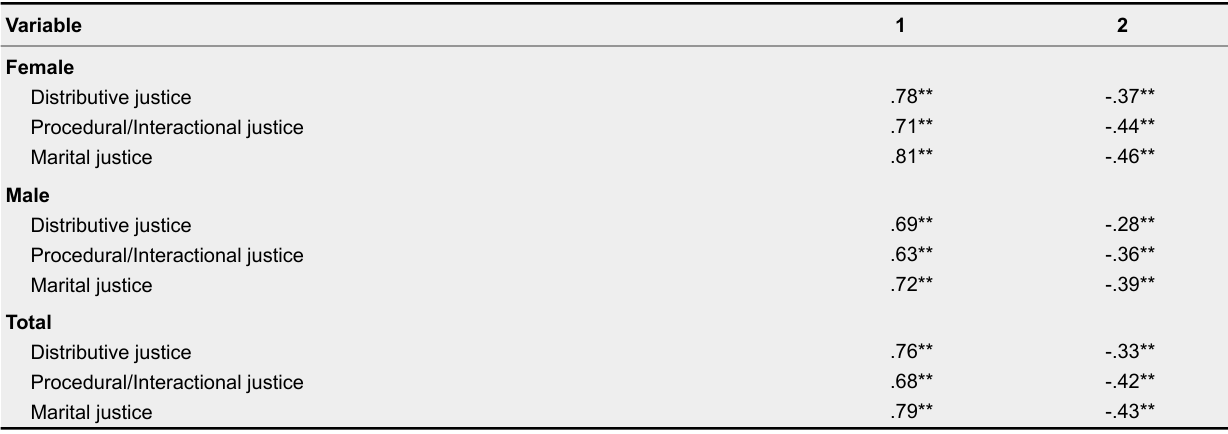
Pearson’s Correlation Coefficients Between Subscales of the Marital Justice Scale (MJS) With Revised Dyadic Adjustment Scale (RDAS) and Marital Conflict Questionnaire (MCQ)